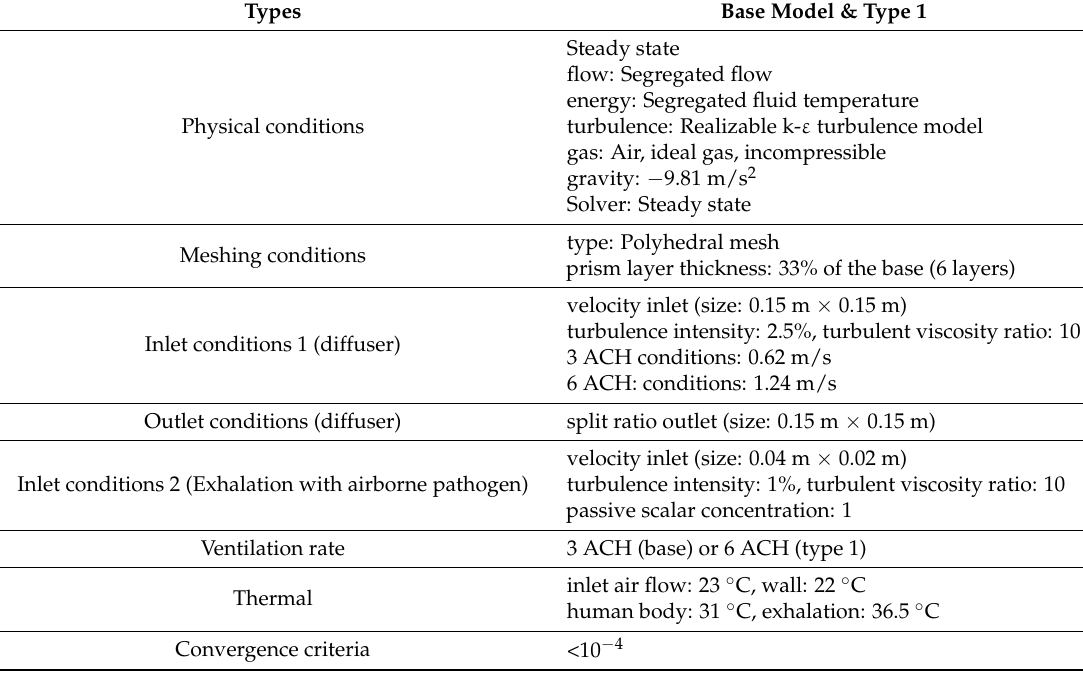
Table 1. Boundary conditions in the computational fluid dynamics (CFD) simulations.